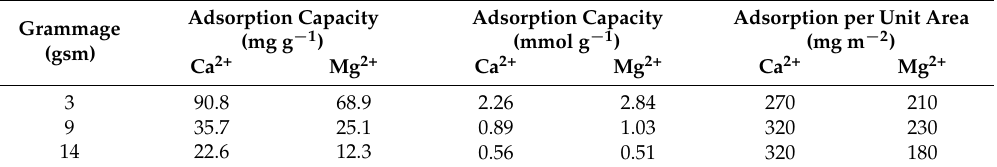
Table 2. Adsorption capacities of Ca 2+ and Mg 2+ for EPT-CNF nanopapers with 3, 9, and 14 gsm, respectively.